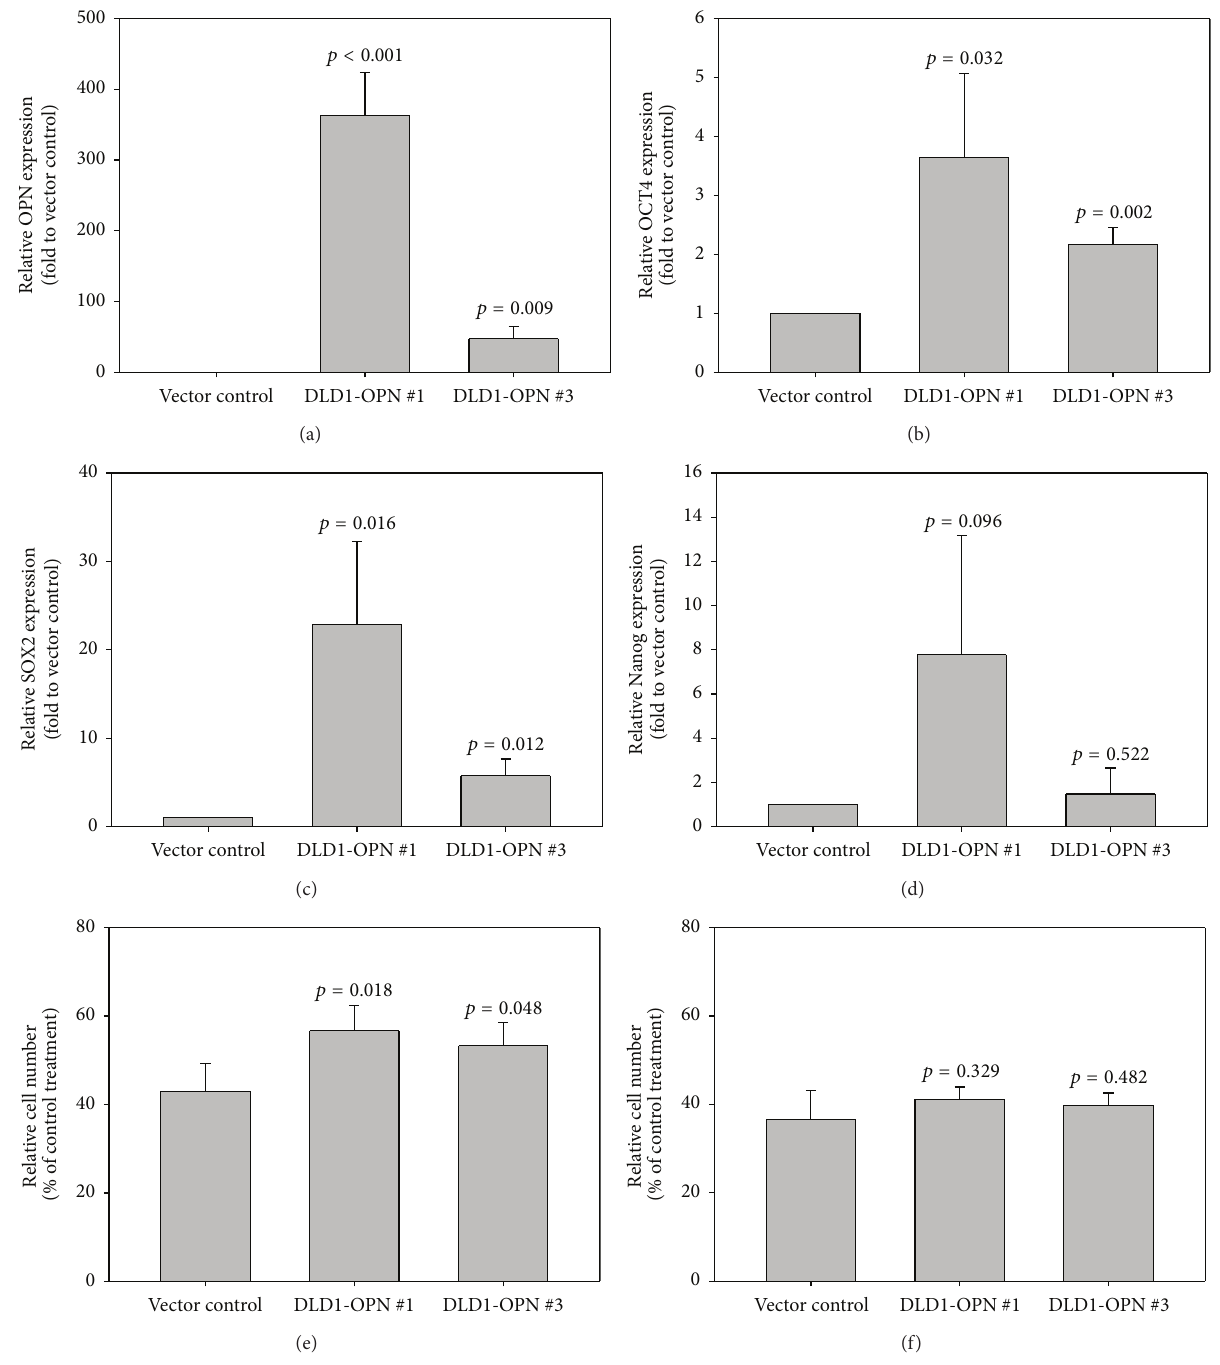
Figure 2: Relative overexpression (expressed as ΔΔ Ct ( Δ Ct of CRC −Δ Ct of nontumor)) of (a) OPN, (b) OCT4, (c) SOX2, and (d) Nanog in DLD1-OPN stable clones #1 and #3 and the vector control; the relative number of viable cells (expressed as percentage of viable cells when compared with vehicle treated cells) after 72-hour treatment of (e) 5 𝜇 M oxaliplatin and (f) 50 𝜇 M 5FU.